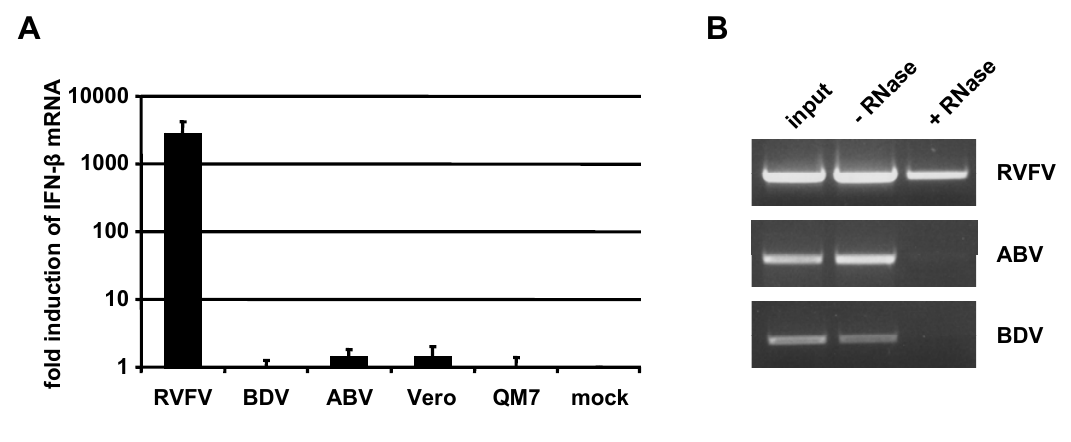
Figure 5. Evasion of host defence by ABV attributed to 5’-monophosphorylated genome ends. ( A ) 293T cells were transfected with total RNA isolated from uninfected Vero or QM-7 cells, or from cells infected with RVFV, BDV or ABV, respectively. At 8 h post transfection, RNA of the transfected cells was isolated and analyzed for IFN- β mRNA induction by qRT-PCR. Values are expressed relative to the mock control. Data shown reflect the average of two independent experiments with duplicates. ( B ) RNA isolated from partially purified virus preparations was digested at 37° for 30 min with the 5’-monophosphate-specific exonuclease Terminator  that specifically digests 5’-monophosphorylated but not 5’-triphosphorylated RNA (+ RNase). An untreated sample (- RNase) served as control. Terminator  -resistant RNAs in samples from stocks of RVFV, BDV or ABV were visualized by RT-PCR analysis using primer pairs specific for the three